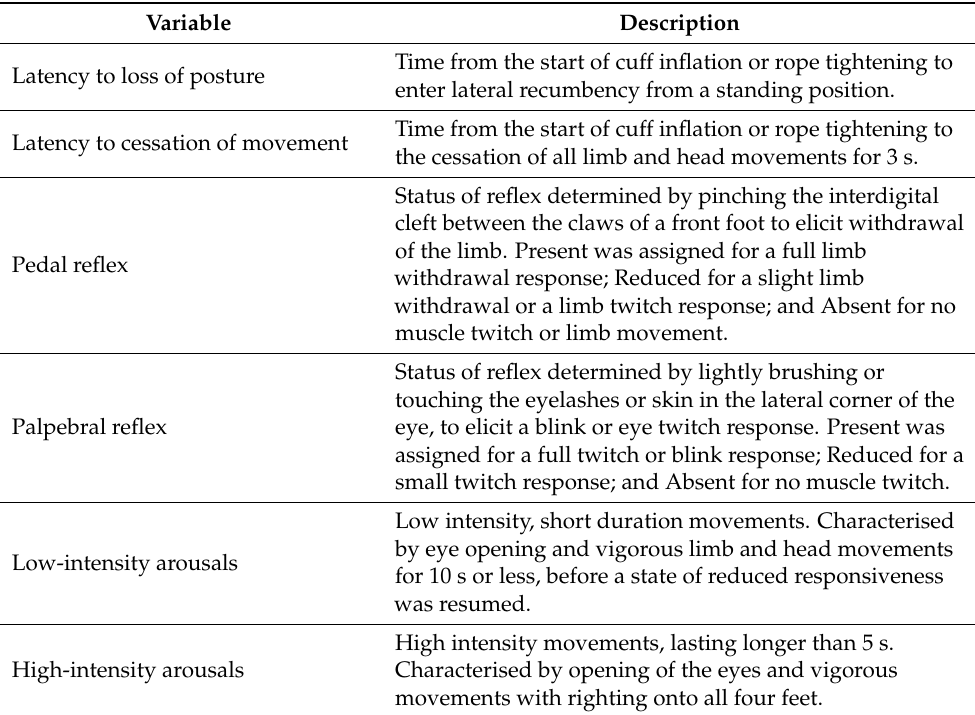
Table 1. Behavioural responses and neural reflexes [21,22] recorded during the 10-min thoracic squeeze